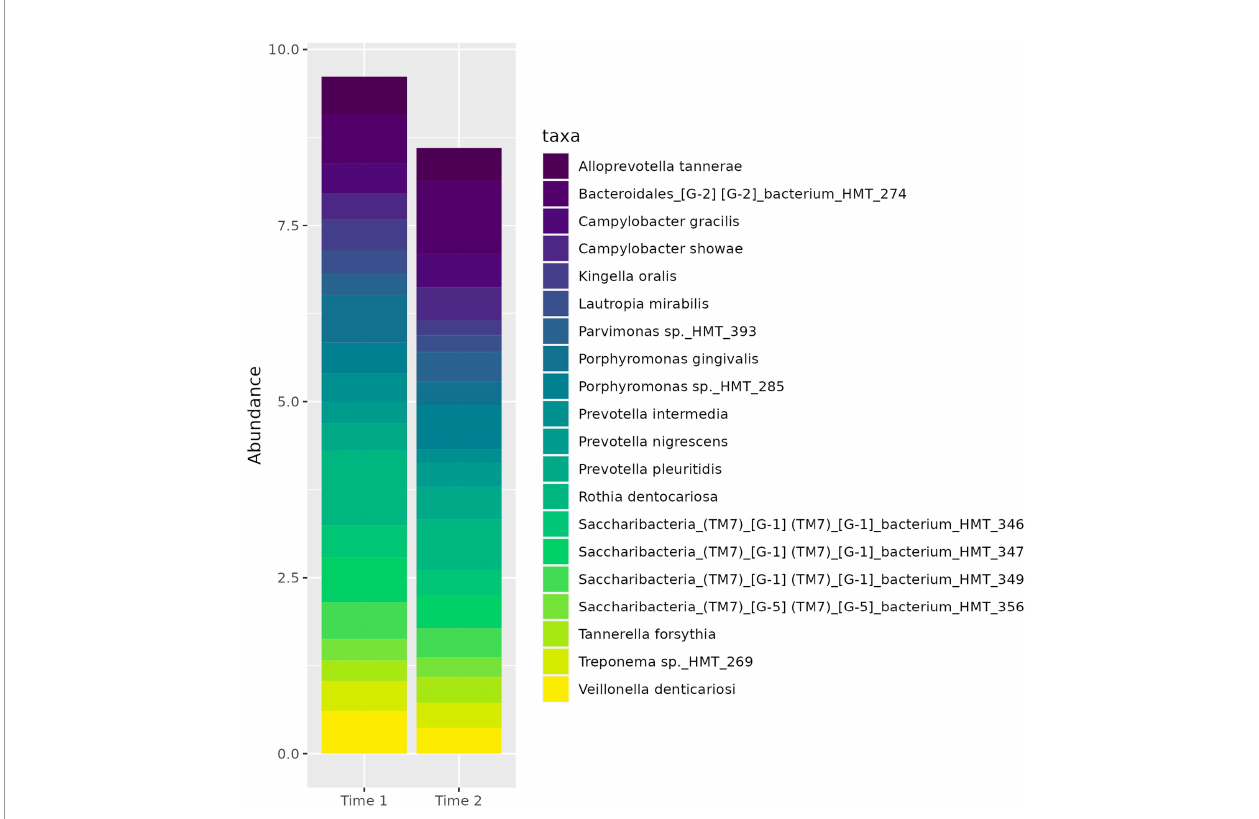
TABLE 3 | Six taxa identi fi ed to have signi fi cantly different relative abundances between early and late pregnancy. Taxa Early Pregnancy Mean Relative